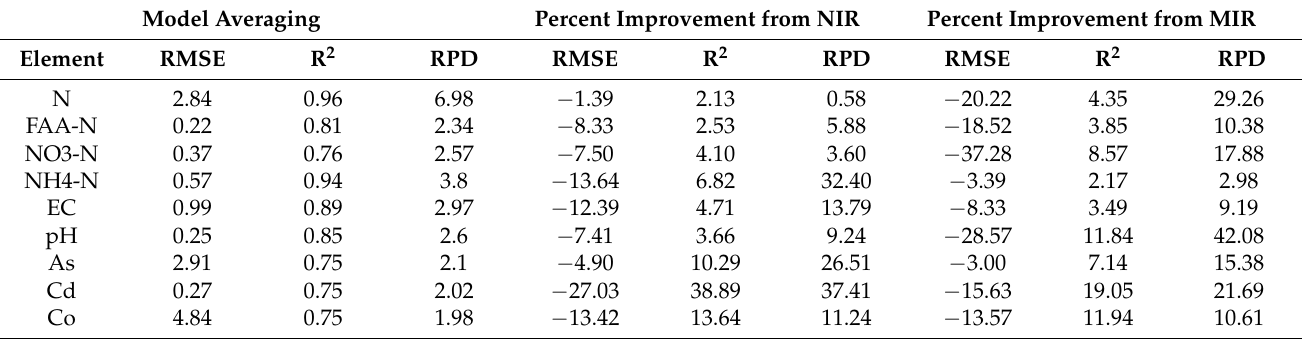
Table 3. The goodness of fit for major nutrients (N. P, K and plant-available form of nitrogen), and other properties derived from model averaging of NIR and MIR prediction results. All units